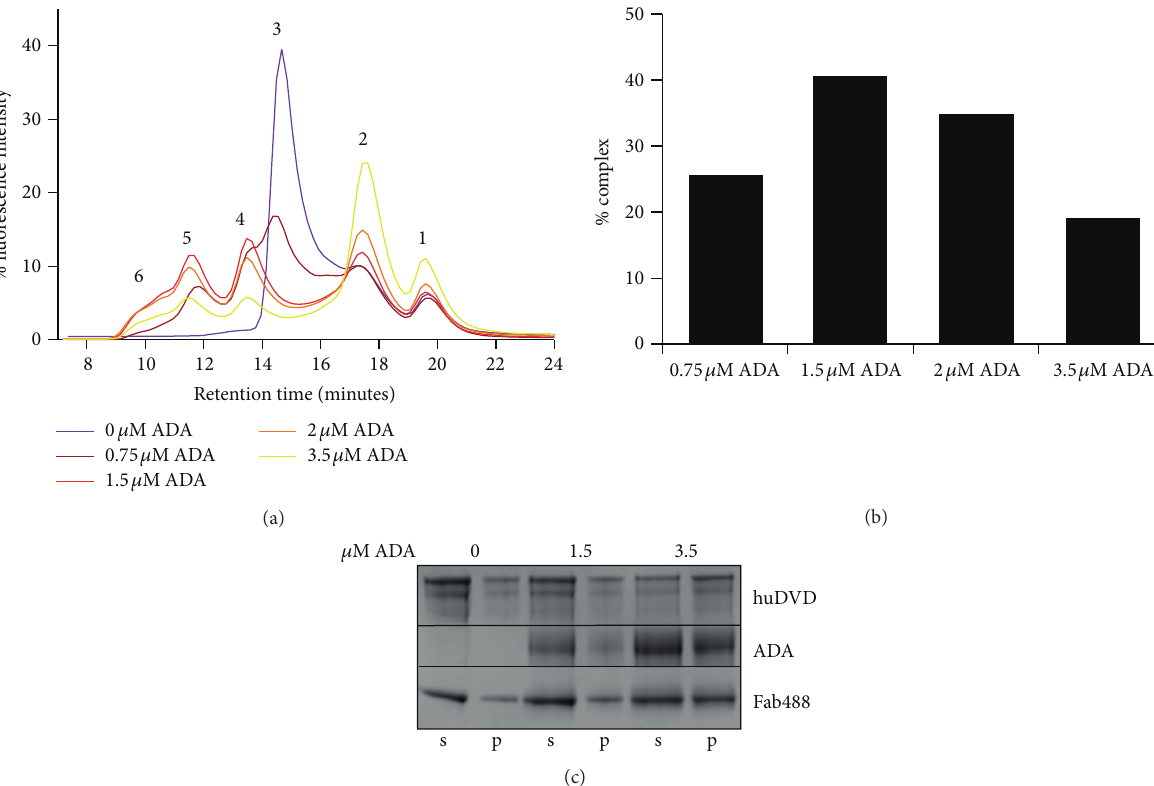
Figure 3: (a) Fab488-huDVD-ADA complexes prepared with ADAs purified from rabbit serum. 0.83 𝜇 M huDVD, 678 nM Fab488, and 0.75, 1.5, 2, and 3.5 𝜇 M ADA were incubated in 20% cynoserum as described in Section 2 and separated by size exclusion chromatography with fluorescence detection. Peak 1 is the free dye (DyLight 488), peak 2 is Fab488, peak 3 is the complex of Fab488 and huDVD, peak 4 is the complex of Fab488 and huDVD and one ADA, peak 5 is the complex of Fab488, one ADA, and two huDVD, and peaks under number 6 represent bigger complexes containing Fab488, huDVD, and ADA. (b) Quantification of fluorescence signal recovery in ADA complexes. Summed peak areas from (a) containing ADA (peaks 4–6) were set in relation to the fluorescence intensity of the whole elution profile and are shown as % complex. (c) Supernatant pellet experiment with ADA complexes. Coomassie stained SDS-PAGE showing the pellet (p) and the supernatant fraction (s) of samples containing 0, 1.5, or 3.5 𝜇 M ADA, Fab488, and huDVD prepared as in (a). The samples were treated as described in Section 2. The pellet fraction contained 20% of the reaction volume, whereas the supernatant fraction contained 80% of the reaction volume. Aggregation occurs when more than 20% of total protein amount are in the pellet